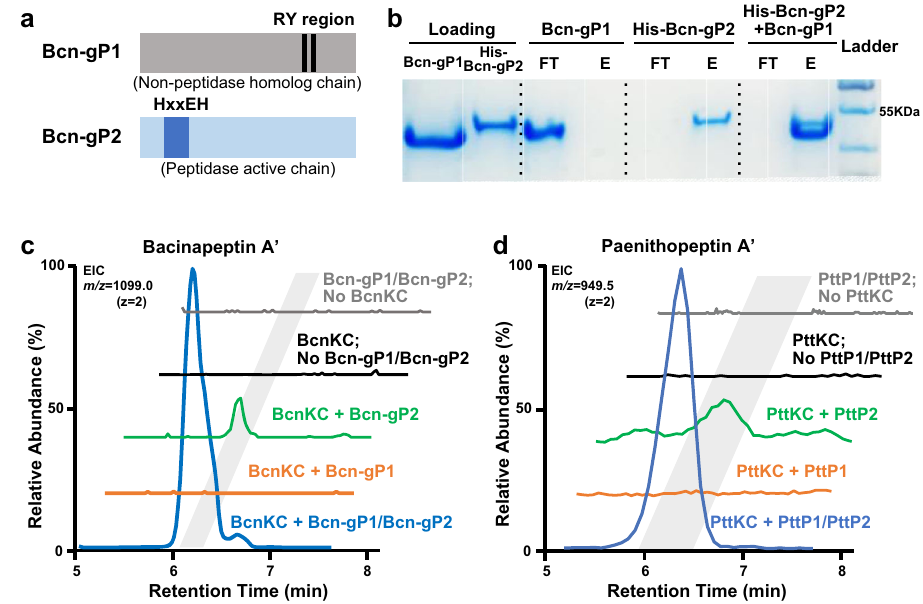
Fig. 4 Bioinformatics analysis and enzymatic characterization of Bcn-gP1/Bcn-gP2 and PttP1/PttP2. a Representation of the Zn 2 + -binding HXXEH motif of Bcn-gP2 and PttP2 as well as the substrate-binding R/Y region of Bcn-gP1 and PttP1. These characteristic features suggested Bcn-gP1/Bcn-gP2 and PttP1/PttP2 as heteromeric M16B metallopeptidases. b A pull-down assay showing protein-protein interaction between Bcn-gP1 and Bcn-gP2. His 8 -tag-free Bcn-gP1 was immobilized on the nickel af fi nity column only when His 8 -tagged Bcn-gP2 was present, as re fl ected by examining the fl owthrough using sodium dodecyl sulfate polyacrylamide gel electrophoresis (SDS-PAGE). The experiment was repeated three times independently with similar results. FT: fl owthrough; E: elute. c Extracted ion chromatogram (EIC) showing in vitro characterization of the proteolytic activity of Bcn-gP1/Bcn-gP2. Bcn-gP1 and Bcn-gP2 were required simultaneously to produce the highest yield of bacinapeptin A ′ . In addition, the lack of BcnKC in the assay completely abolished the production, suggesting that Bcn-gP1/Bcn-gP2 shows speci fi city towards BcnKC-modi fi ed precursor bearing a labionin ring. In the assay without BcnKC, m / z 1216.1 ( z = 2) was also used for EIC detection of potential unmodi fi ed core peptide. d Extracted ion chromatogram (EIC) showing in vitro characterization of the proteolytic activity of PttP1/PttP2. PttP1 and PttP2 were required simultaneously for the highest production yield and the lack